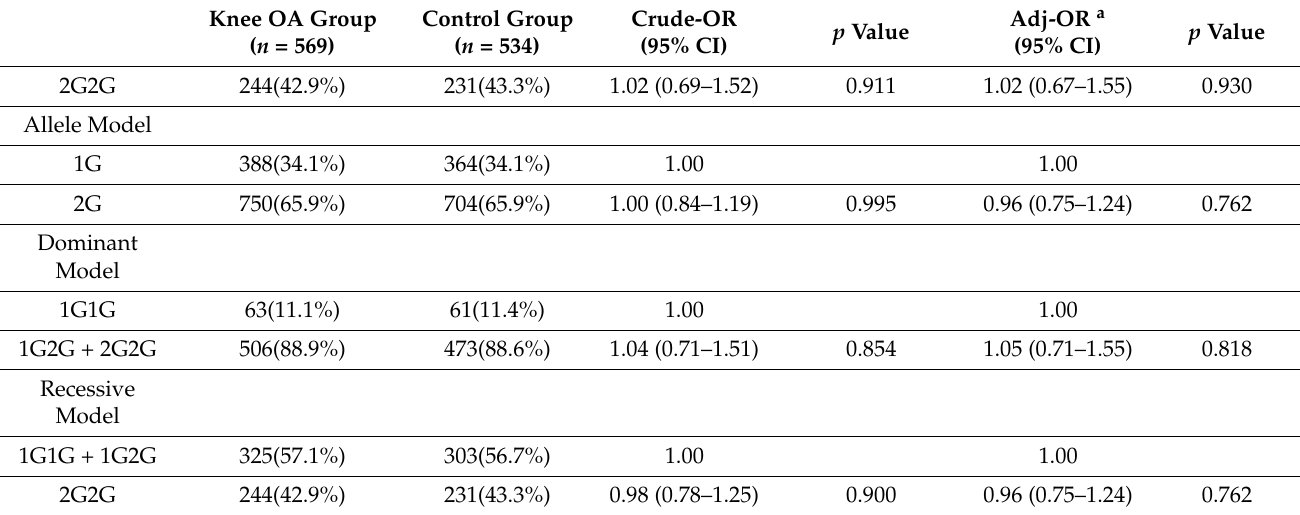
Table 2. Cont. Table 2. Association between genetic polymorphism of MMP1 rs1799750 and knee OA.